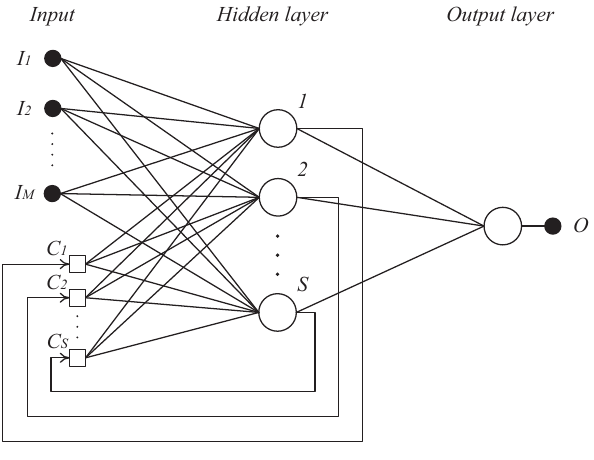
Fig. 2. Architecture of two-layer back-propagation neural network